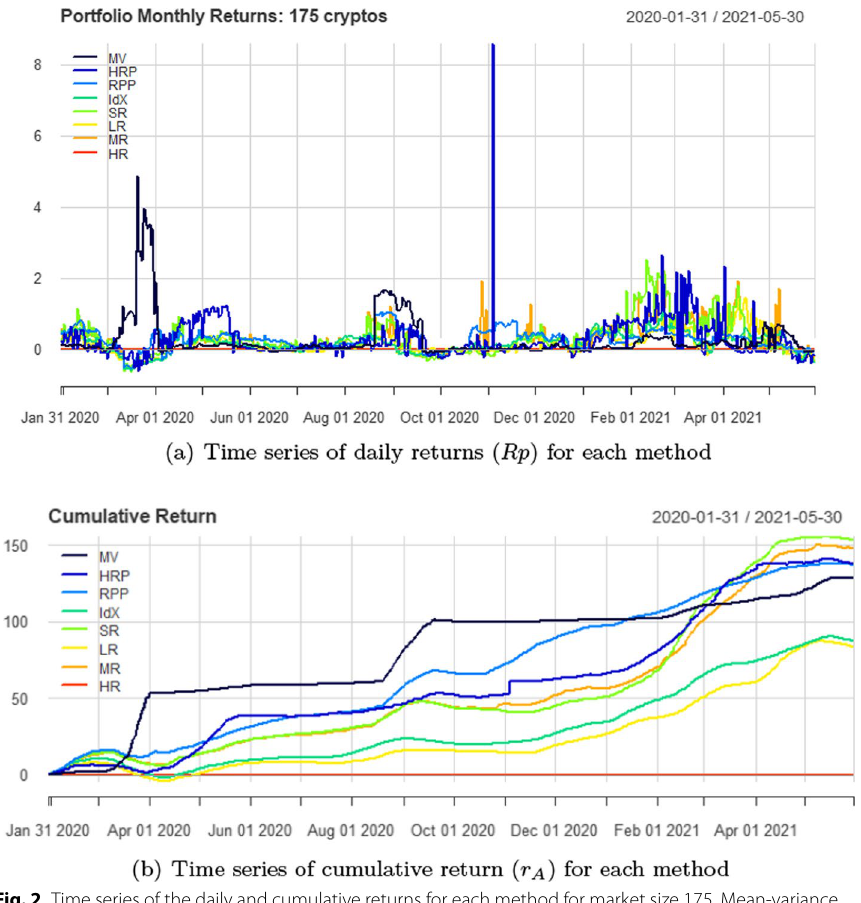
Fig. 2 Time series of the daily and cumulative returns for each method for market size 175. Mean-variance (MV), Hierarchical Risk Parity (HRP), Risk Parity Portfolio (RPP), Index CCI30 (IdX), Sharpe Ratio strategy (SR), Low-Risk strategy (LR), Mean-Risk strategy (MR) and High-Risk strategy